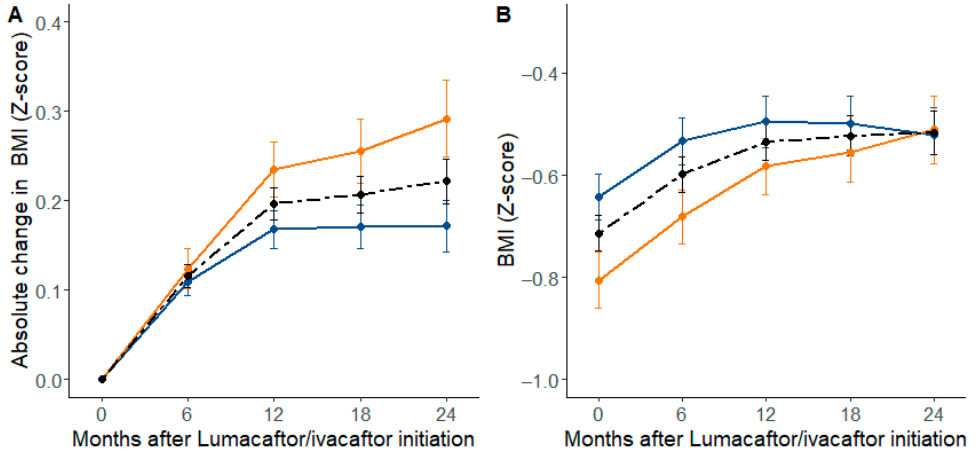
Figure 3. Nutritional status (BMI Z-score) over 2 years following initiation of combined lumacaftor/ivacaftor therapy according to gender with 95% CIs, ( A ) mean of absolute changes from baseline, ( B ) mean of BMI Z-score, in 765 people with cystic fibrosis (pwCF). Men are in blue, women in orange and the dotted lines show the overall change in the 765 pwCF.